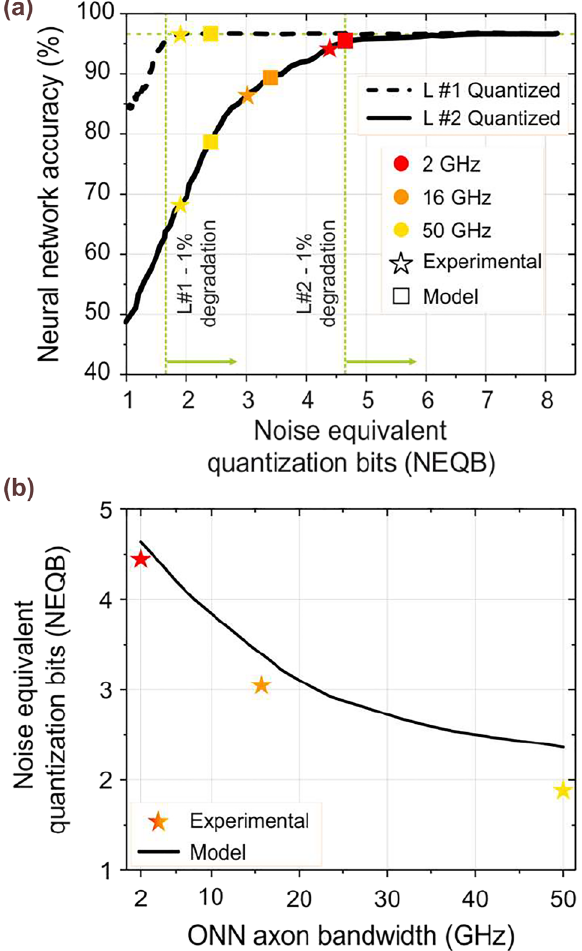
Figure 6: Experimental – model performance comparison: (a) NN inference accuracy when the first (dashed line) and the second (solid line) layers are quantized with a NEQB in [1,8]. Scatter points correspond to the modeled (rectangles) and experimental (stars) respective values at ONN axons’ bandwidth equal 2 (red), 16 (orange), and 50 (yellow) GHz (b) NEQB versus ONN axon’s bandwidth derived via the software model (solid line) and the experiment (star scatter